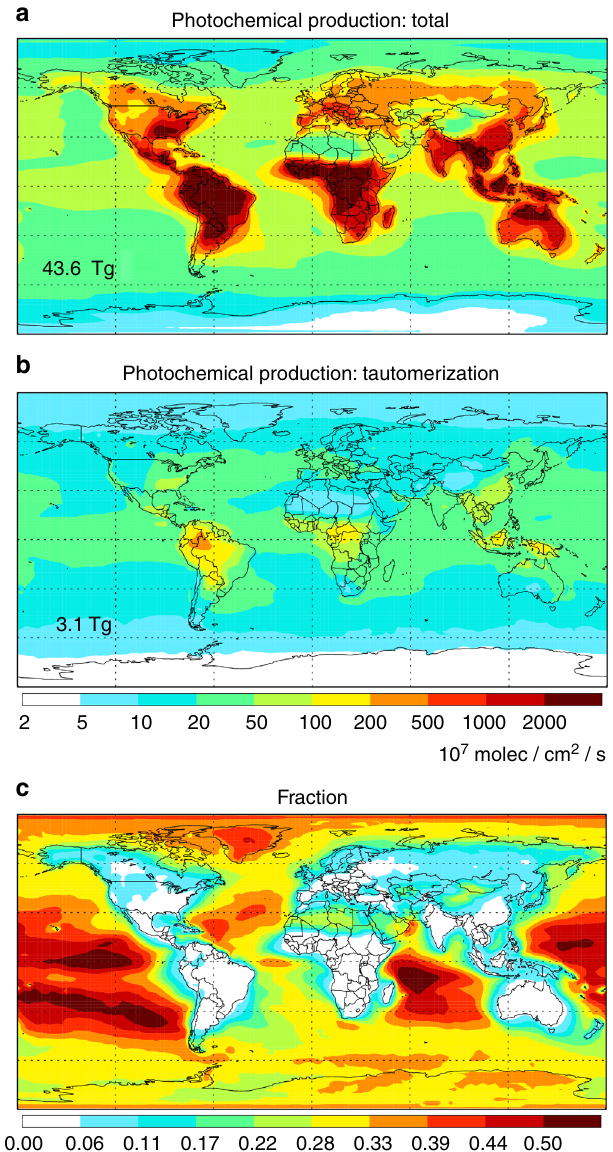
Fig. 5 Column-integrated formic acid (FA) production rates as simulated by the GEOS-Chem 3D chemical transport model as a function of latitude and longitude. a Total FA production from all chemical pathways. b FA produced via photo-tautomerization of AC. c Fraction of total FA produced via